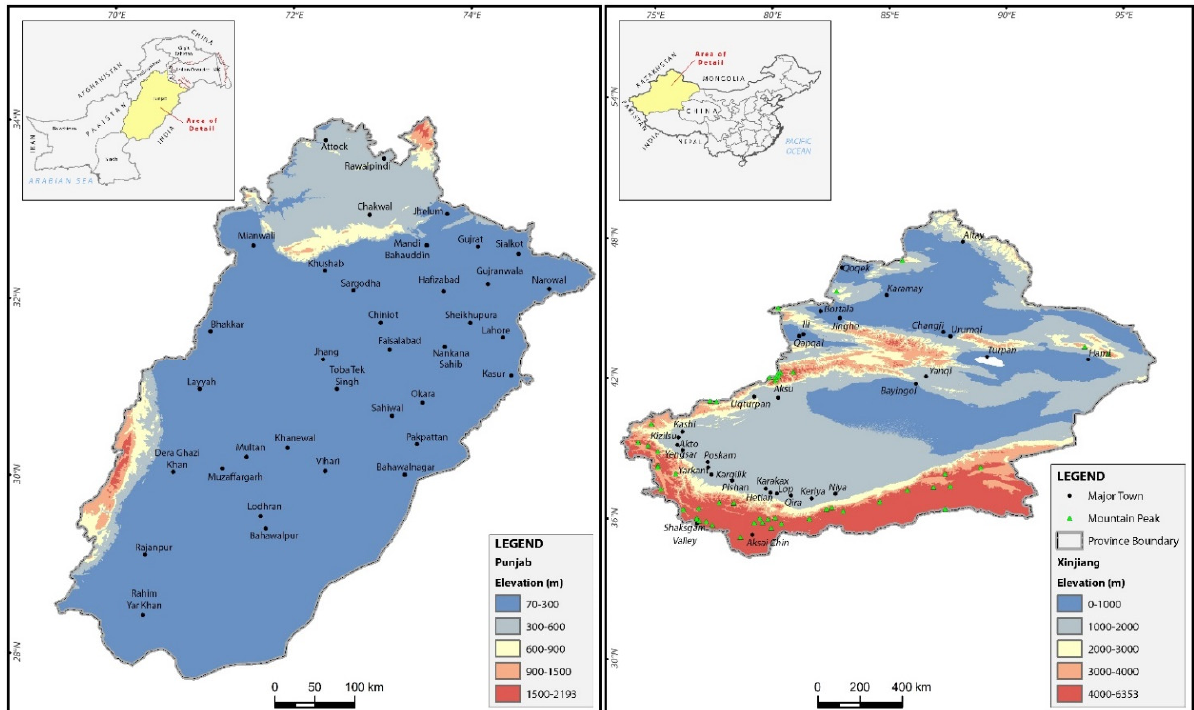
Figure 1. Location map of the study areas of Xinjiang province in China, and Punjab province in Pakistan on the basis of topographic elevation. Table 1. Comparison list of progressive, heat-tolerant, medium to short-duration, film mulching, local and international, cotton varieties of China (South and North Xinjiang), and Pakistan (Central and South Punjab) in cotton planting region. Country